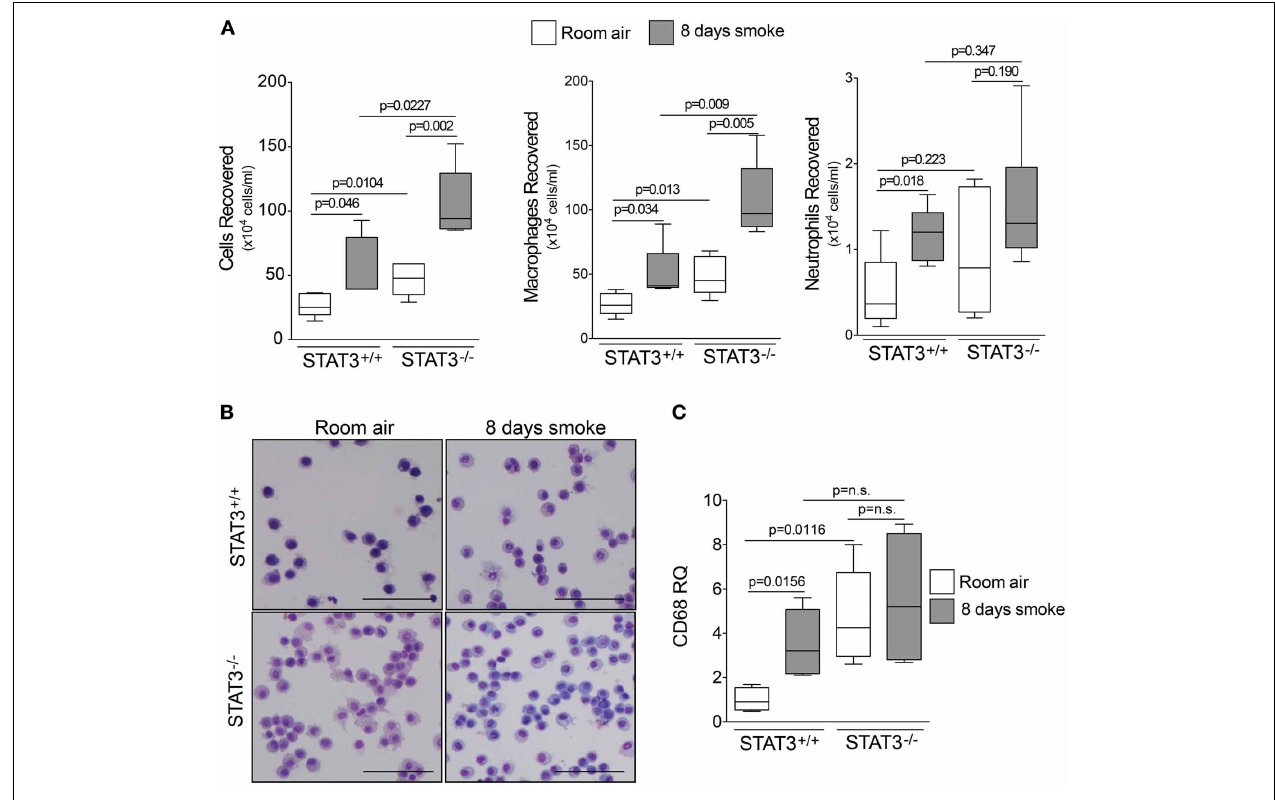
FIGURE 2 | STAT3 expression subdues BALF cellularity. Three-month old STAT3 + / + and STAT3 − / − mice were exposed to room air (white bars) or cigarette smoke (black bars) for 4h daily for 8 days. The mice were euthanized 12h post the last smoke exposure and (A) BALF cellularity was measured by bright field microscopy. BALF macrophages and neutrophils were determined by quick diff staining. (B) A typical representative